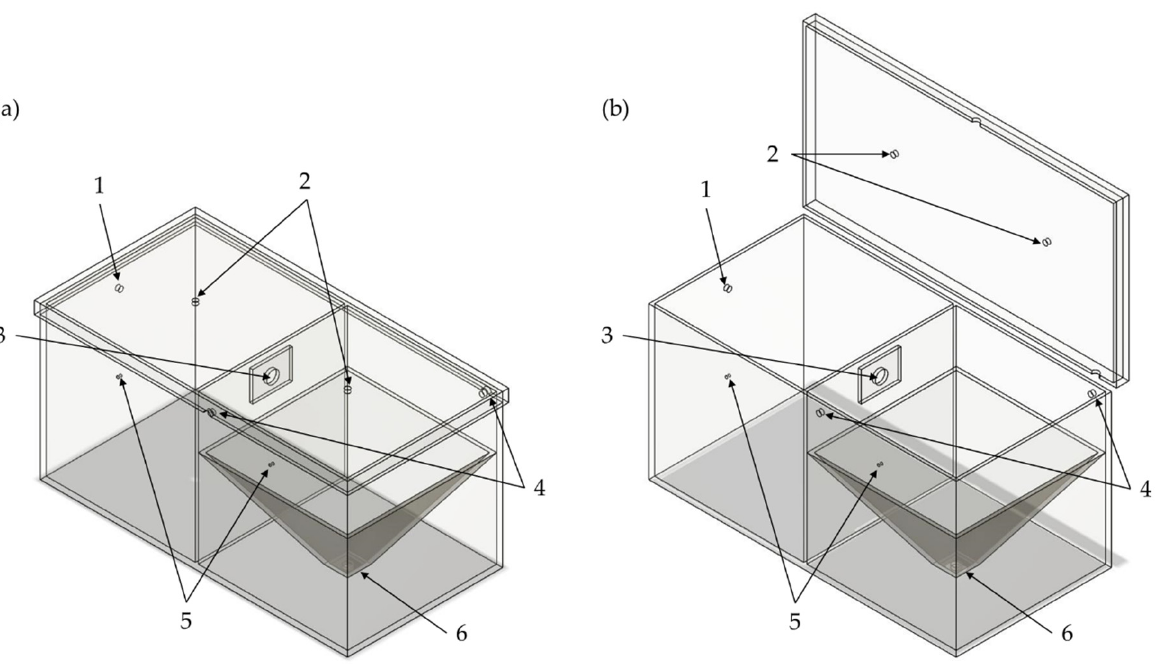
Figure 2. Schematic illustration of the TCS ( a ) in the closed state and ( b ) in the open state. 1: orifice for pressure compensation of the emission chamber; 2: orifices for the double-acting ball valves; 3: orifice for the connection between the emission and the detection chamber; 4: orifices for pressure compensation of the detection chamber; 5: orifices for the differential pressure gauge; 6: orifice for the IOM sampler.